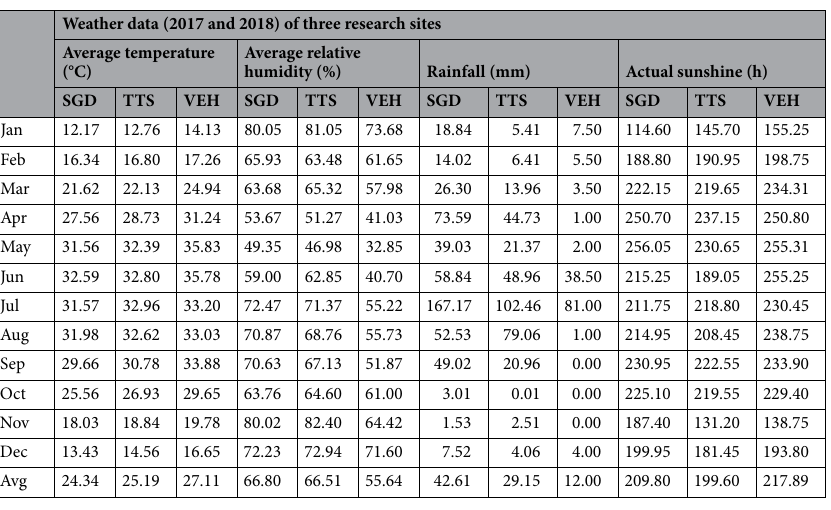
Table 1. Weather data of three